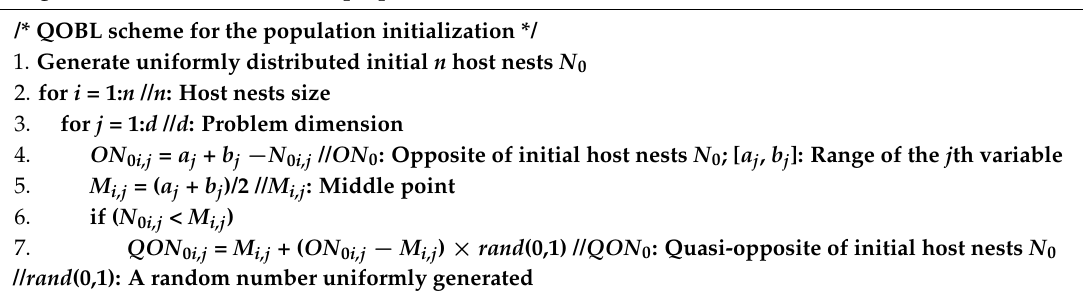
Algorithm 2: Pseudocode of the proposed